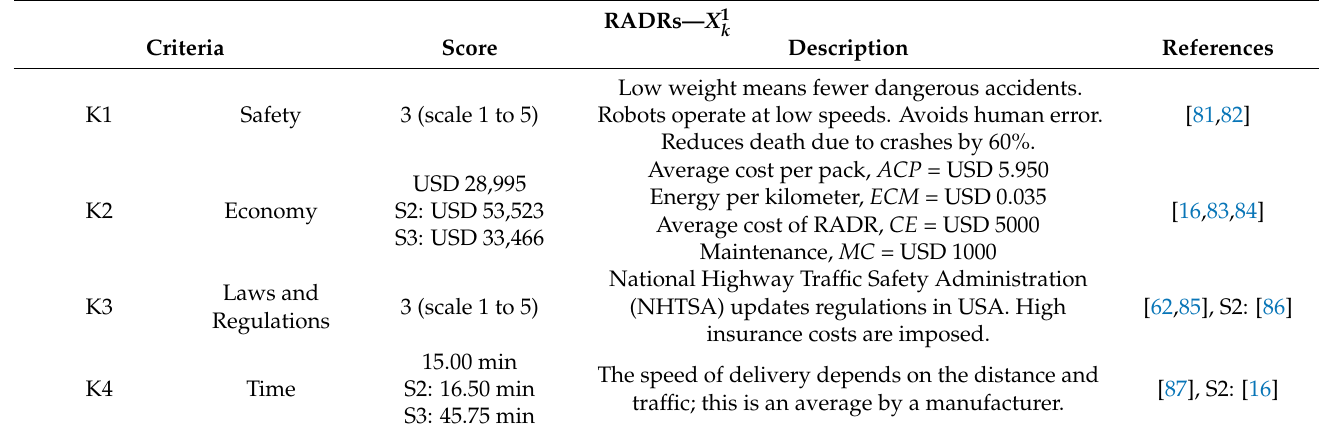
Table 2. RADRs scores in the case of S1 (unless otherwise